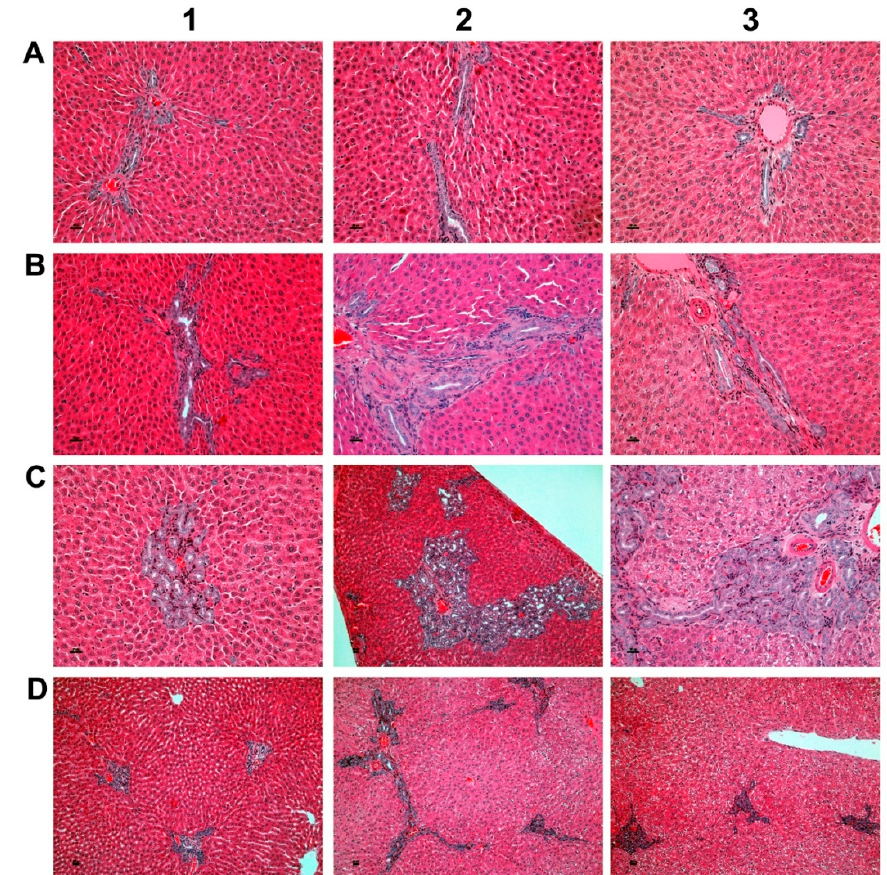
Figure 1. Bile duct hyperplasia after repeated oral dosing of rats with a Petasites hybridus